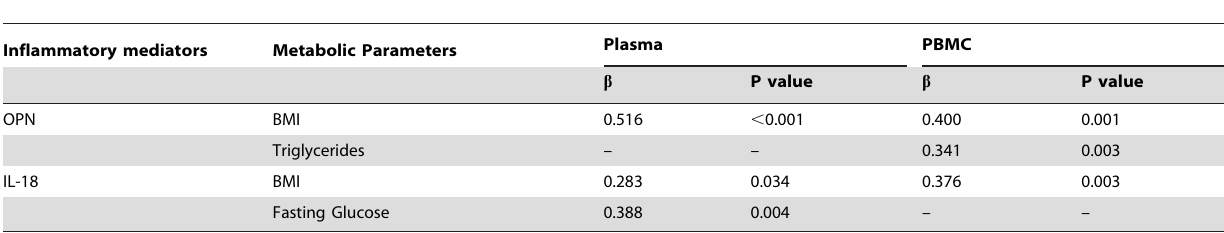
Table 3. Multiple stepwise linear regression analysis to identify clinical variables (metabolic parameters) associated with OPN or IL- 18 level as a dependent